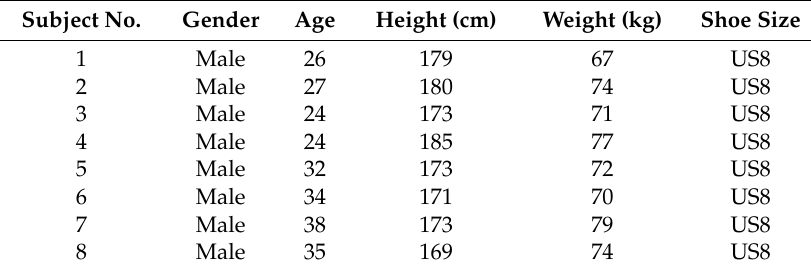
Table 1. Body state information of